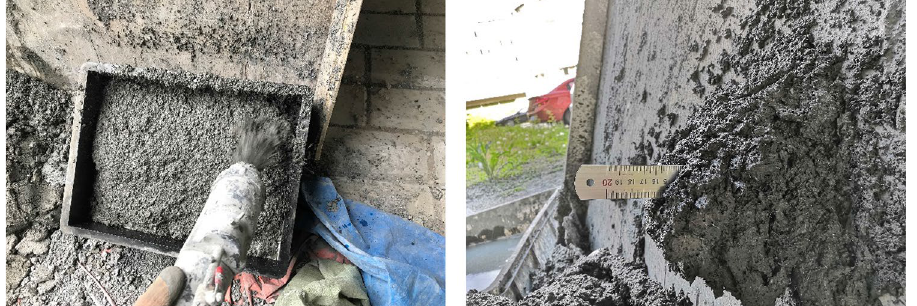
Figure 1. The tester performs the spray and thickness of single point